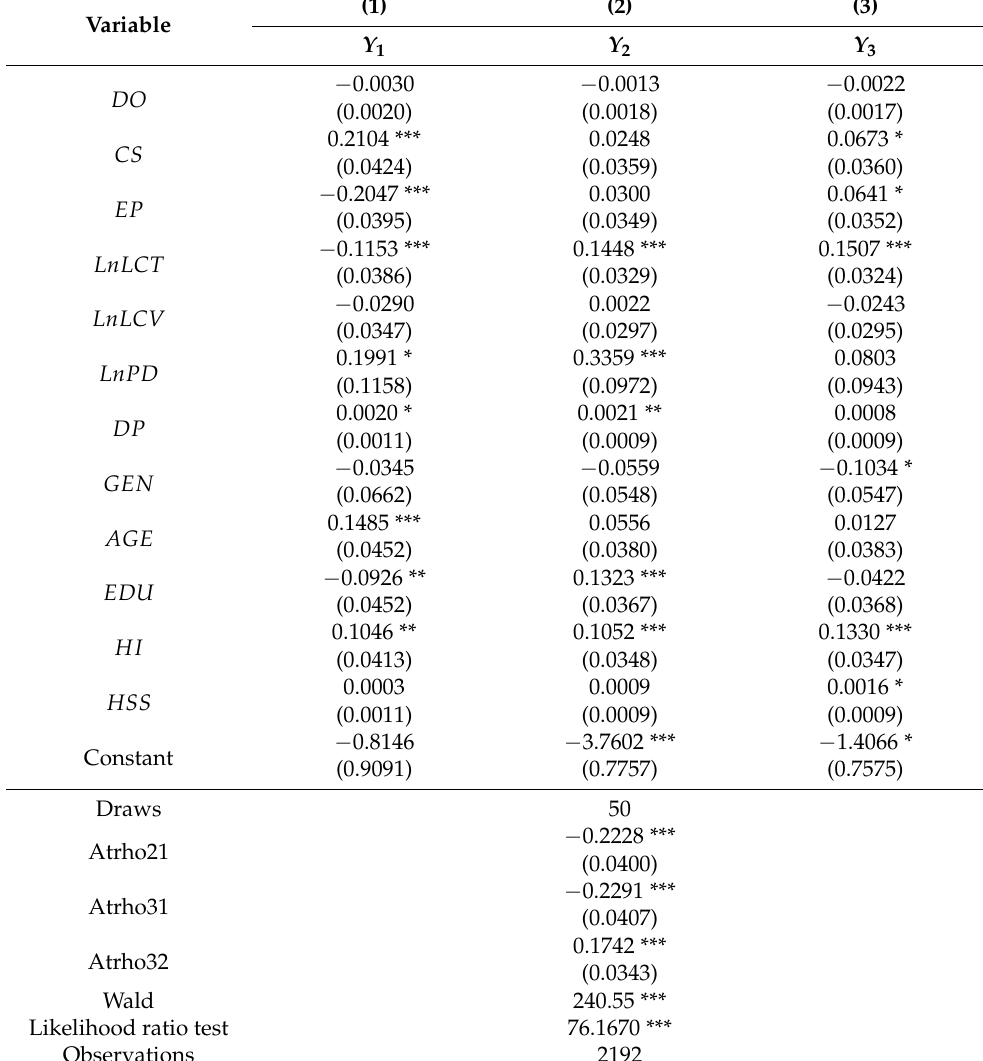
Table 5. Baseline regression